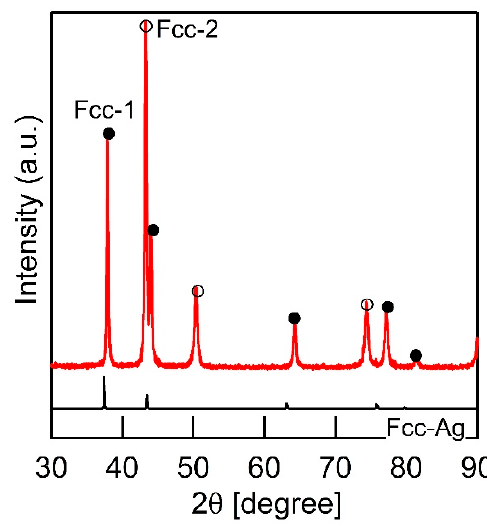
Figure 3. XRD pattern of arc-melted ingots in the equiatomic AgCoCrFeMnNi high-entropy alloy (HEA).